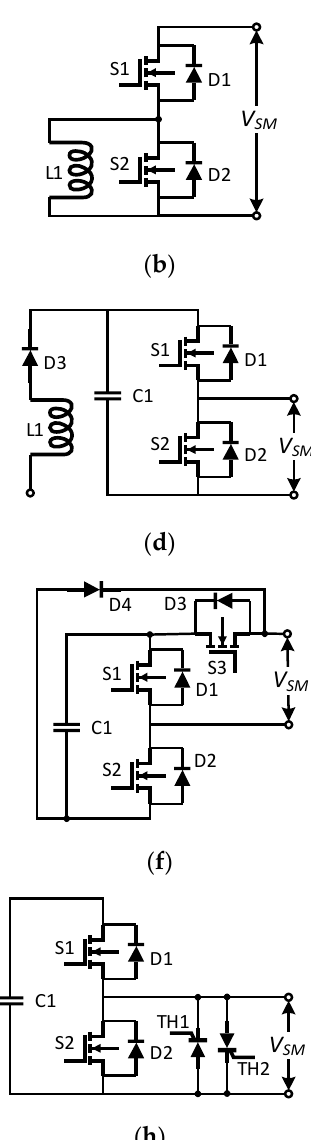
Figure 2. Two-level submodule topologies: ( a ) half-bridge submodule (HBSM); ( b ) current source Figure2. Two-levelsubmoduletopologies: ( a )half-bridgesubmodule(HBSM);( b )currentsourceHBSM; HBSM; ( c ) full-bridge structure (FBSM); (d) self-balancing submodule (SBSM); ( e ) clamp-single ( c ) full-bridge structure (FBSM); ( d ) self-balancing submodule (SBSM); ( e ) clamp-single submodule submodule (CSSM) type- Ⅰ ; ( f ) CSSM type- Ⅱ ; ( g ) Single-thyristor HBSM; ( h ) Double-thyristor HBSM. (CSSM) type-I; ( f ) CSSM type-II; ( g ) Single-thyristor HBSM; ( h ) Double-thyristor HBSM. A kind of self-balancing submodule (SBSM) is introduced in [40,41]. It is composed of the